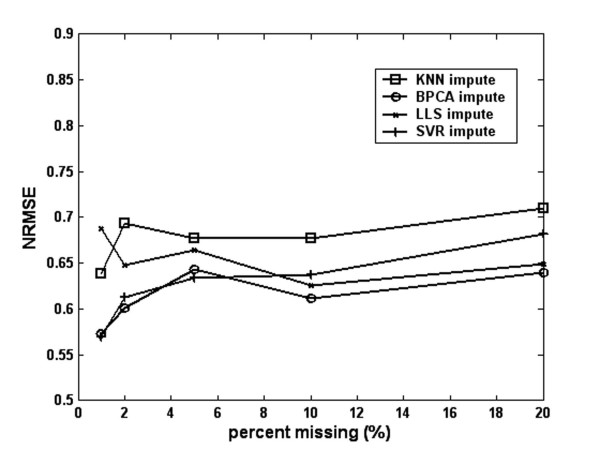
Performance of the four methods on data C.